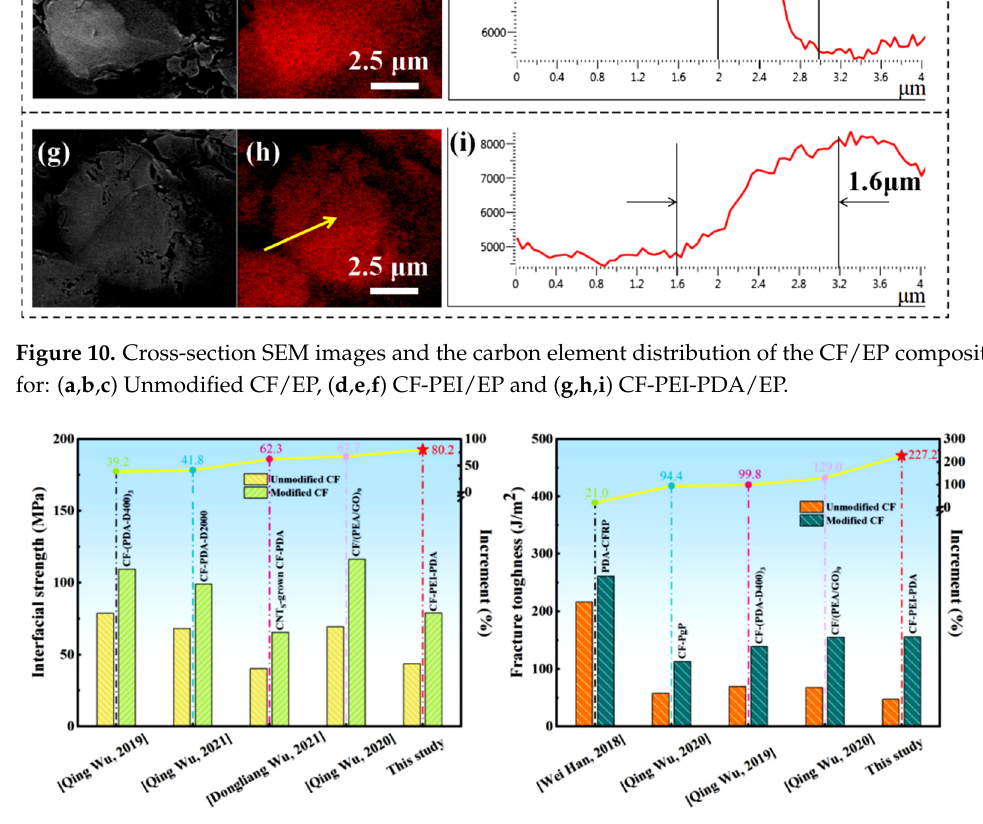
Figure 11. Comparison of interfacial strength and fracture toughness improvement in this work with other composites treated with different sizing agents.